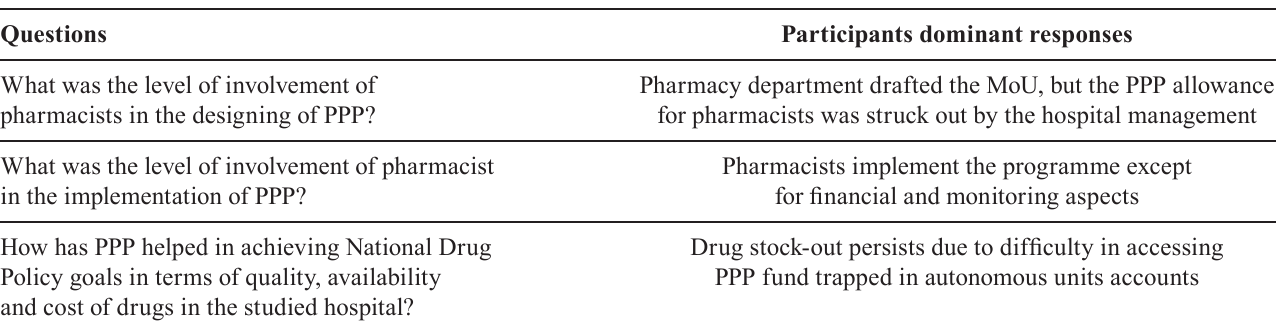
TABLE III – Pharmacists’ involvement in the PPP model design and implementation in the hospital